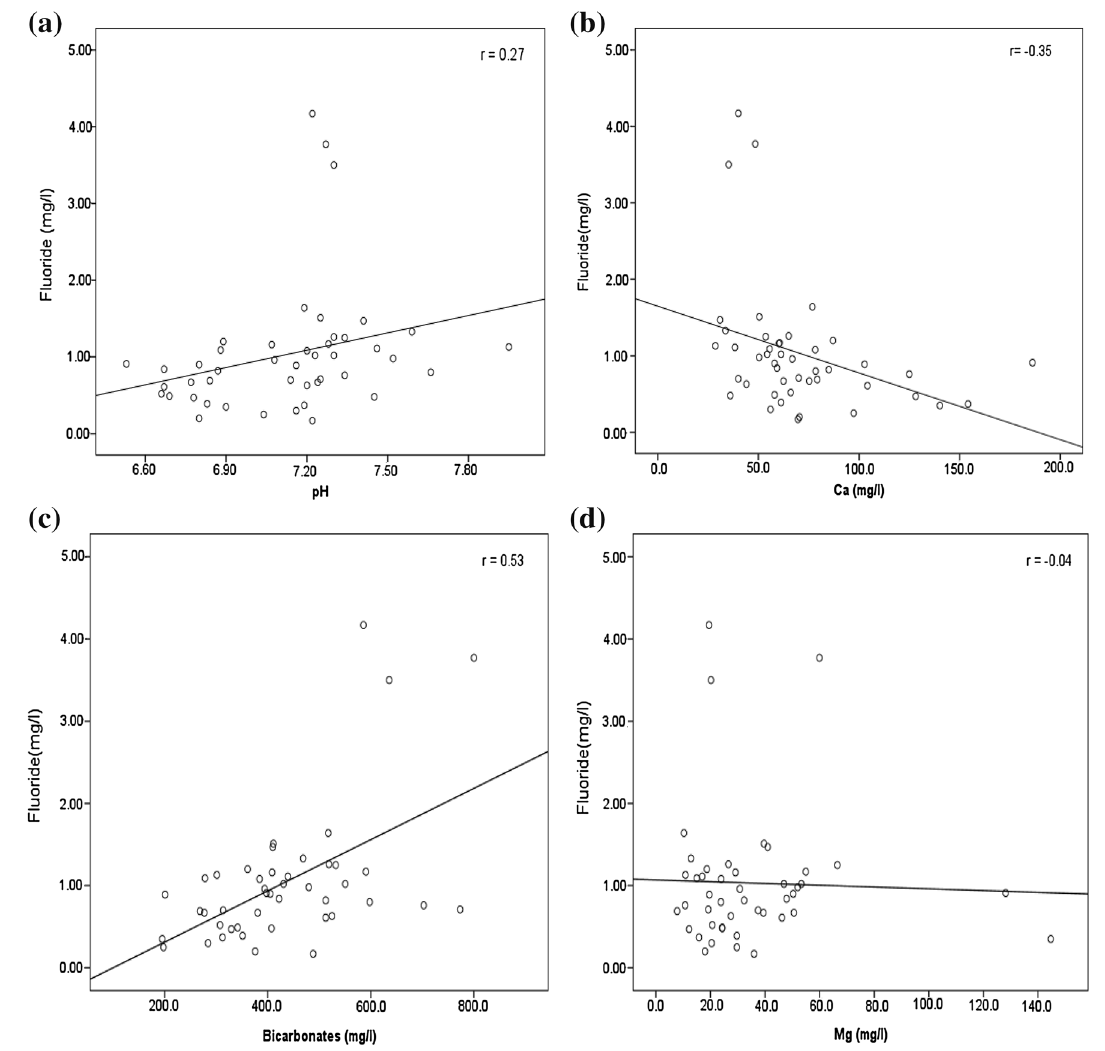
Fig. 2 Correlation graphs of some hydro chemical parameters of groundwater in Mandvi Taluka, Surat district. a Fluoride vs. pH diagram showing a positive correlation. b Fluoride vs. calcium negative